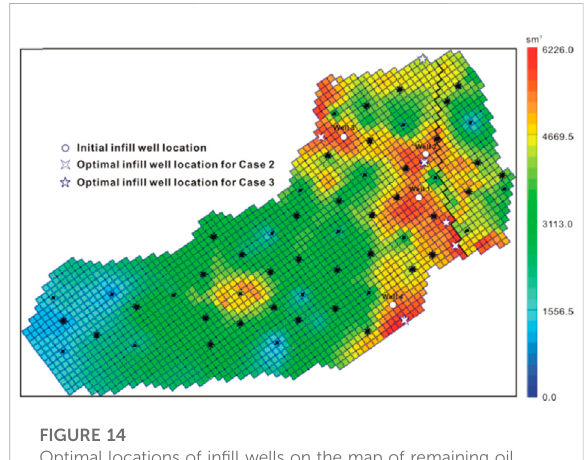
FIGURE 14 Optimal locations of in fi ll wells on the map of remaining oil distribution for two optimization cases in the fi eld